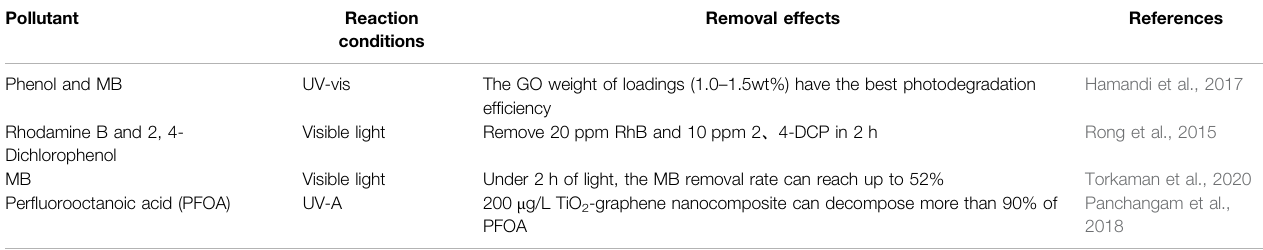
TABLE 2 | The removal effects of 2D-GTC on some organic pollutants.